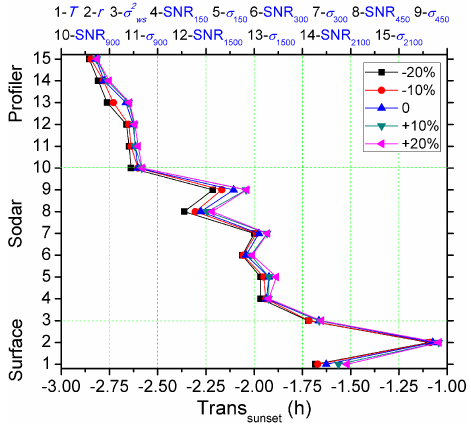
Figure 5. The distributions of Trans sunset as obtained by differ- ent surface state variables for (a) winter (b) summer, (c) south- west monsoon and (d) northeast monsoon, depicting the seasonal variability in the start time of the transition. The distributions for Trans sunset as obtained by sodar-derived range-corrected SNR and σ at 300m for (e) winter, (g) summer, (i) southwest monsoon and (k) northeast monsoon, respectively. (f) , (h) , (j) and (l) are the same as (e) , (g) , (i) and (k) , except for profiler-derived range-corrected SNR and σ at